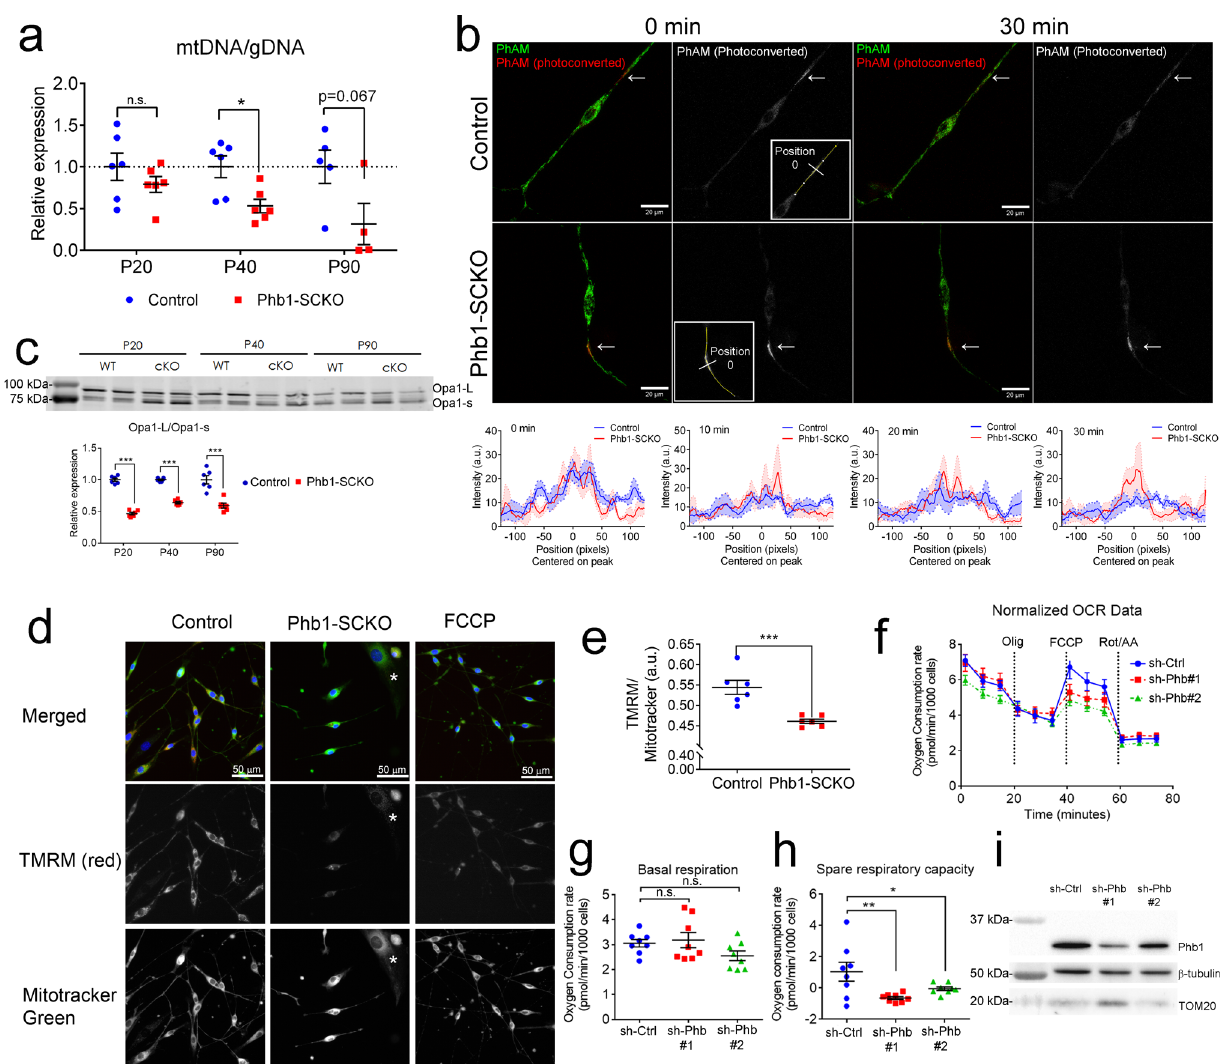
Fig. 4 Mitochondria of Phb1-SCKO are dysfunctional. a The mitochondrial DNA (mtDNA) content is decreased in Phb1-SCKO mice (red) compared to controls (blue) starting at postnatal day 40 (P40). N = 4 – 6 animals per genotype. Unpaired two-tailed t -test corrected for multiple comparisons using the Holm-Sidak method [P20 ( t = 1.114, df = 10, p = 0.29), P40 ( t = 3.068, df = 10, p = 0.012), P90 ( t = 2.174, df = 7, p = 0.066)]. b Mitochondrial dynamics is affected by deletion of Phb1 in primary mouse SCs. Top: PhAM fl uorescence was photoconverted using a focal laser stimulation and dynamics of the photoconverted mitochondria (arrows) were observed for 30min. While the PhAM (photoconverted) signal quickly dissipated in the control SCs, it remained stagnant in Phb1-SCKO SCs. Inset: position 0 represents the center of the stimulated area. Bottom: quanti fi cation of PhAM (photoconverted) signal around the stimulated area at different time points. Mean (line) and SEM (shaded area) of the signal is reported. A.u. = arbitrary units. N = 6 – 7 cells per genotype. c Processing of the mitochondrial fusion protein Opa1 is increased in Phb1-SCKO mice. N = 6 animals per genotype. Unpaired two-tailed t -test [P20 ( t = 16.664, df = 10, p < 0.000001), P40 ( t = 17.015, df = 10, p < 0.000001), P90 ( t = 5.335, df = 10, p = 0.00033)]. d Ablation of Phb1 leads to reduced mitochondrial membrane potential in primary SCs of P40 PHB1-SCKO mice as compared to controls. e Quanti fi cation of ( d ). N = 6 wells per genotype. Unpaired two-tailed t -test ( t = 4.583, df = 10, p = 0.001). Asterisk: fi broblast. f – h In primary rat SCs, Seahorse analyses indicate that Phb1 knockdown with either sh-Phb #1 (red) or sh-Phb #2 (green) does not change basal mitochondrial respiration (One-way ANOVA. F (2, 21) = 2.195, p = 0.1363) ( g ), but impairs the spare respiratory capacity ( h ). Timing of injection of oligomycin (Olig), FCCP, and rotenone (Rot) + antimycin A (AA) are indicated in ( f ). i Western blot illustrating the reduction in levels of PHB1 upon treatment with shRNAs (63% and 21% reduction in PHB1/ β -tubulin ratio for sh-Phb #1 and sh-Phb #2, respectively). N = 8 wells per condition. One-way ANOVA. F (2,21) = 5.594, p = 0.0113; p sh-Phb1#1 = 0.0068; p sh-Phb1#2 = 0.0456. Data are presented as mean ±SEM. * p < 0.05, ** p < 0.01, *** p < 0.001. n.s. non-signi fi converts from a green to a red fl uorescent state. We exposed a focal region of the SCs to the 405 nm confocal laser to promote photoconversion of PhAM and then monitored cells for 30 min, tracking the photoconverted mitochondria. In control SCs, Phb1 in SCs, we performed live imaging of SCs isolated from photoconverted (red) mitochondria dispersed quickly and no Phb1 wt/wt ; P0-Cre; PhAM (Control) and Phb1 fl / fl ; P0-Cre; PhAM (Phb1-SCKO) animals. We took advantage of the photoconver- peak in the red signal is evident at the end of the experiment tible nature of the Dendra2 fl uorophore in the PhAM mice. (Fig. 4b). On the other hand, red SC mitochondria are still When stimulated by visible blue or UV-violet light, Dendra2 present as a group after 30 min in Phb1-SCKO mice (Fig. 4b and